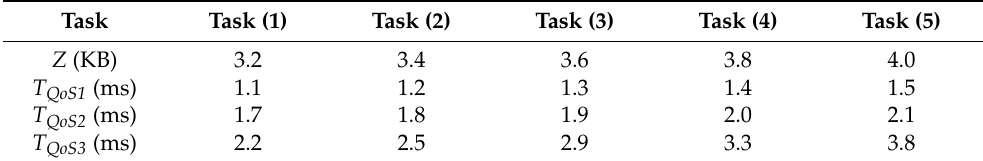
Table 8. Task specifications of high-level devices (HL).